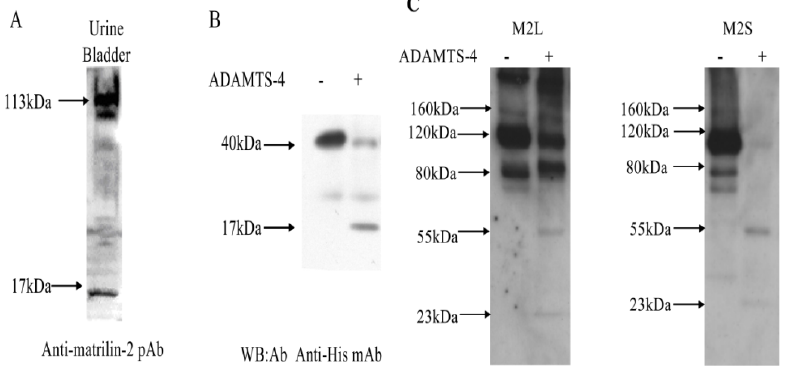
Figure 5. Matrilin-2 proteolytic cleavage in vivo and the proteolysis susceptibility of the splicing variants. ( A ) Matrilin-2 proteolytic cleavage product in mouse urine bladder. Urine bladder from newborn mice was homogenized and analyzed by electrophoresis in a 4%–15% SDS-PAGE gel under reducing conditions, followed by western blot analysis using a polyclonal antibody pM2 against matrilin-2. A full length 113 kDa matrilin-2 monomer and the 17 kDa C -terminal cleavage product were indicated; ( B ) Western blot analysis of C -terminal matrilin-2 proteolytic cleavage product. M2L transfected cells were incubated with ADAMTS-4 for 24 h. Electrophoresis was performed in a 4%–15% SDS-PAGE gel under reduced conditions, followed by western blot analysis using a monoclonal antibody against the His tag at the C-terminus; ( C ) M2L or M2S transfected cells were incubated with ADAMTS-4 for 24 h. Electrophoresis was performed in a 4%–15% SDS-PAGE gel under non-reduced conditions, followed by western blot analysis using a monoclonal antibody against the FLAG tag at the